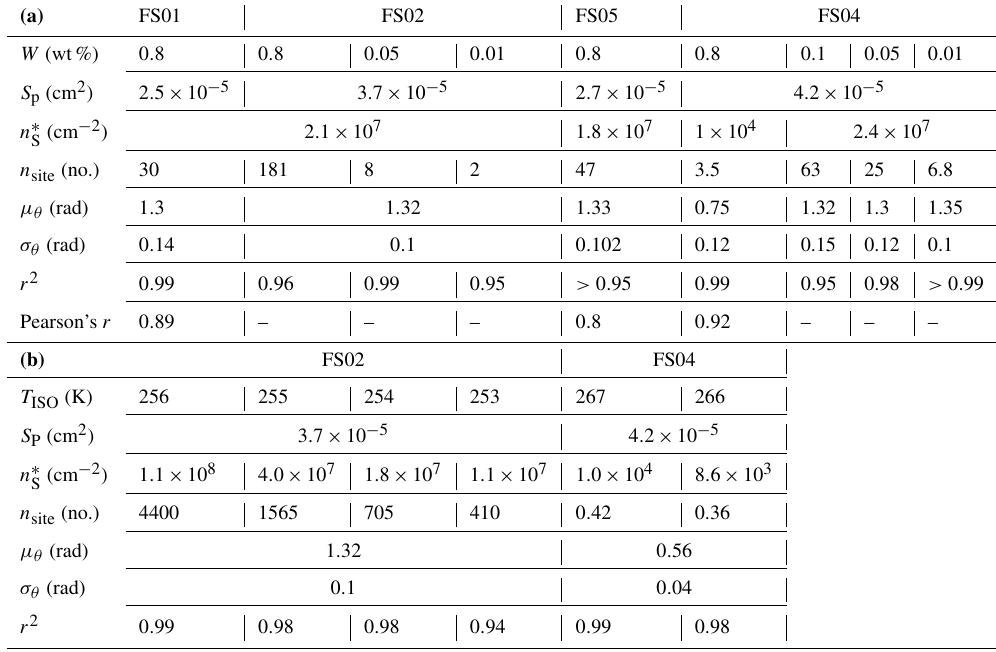
Table 2. (a) SBM parameters obtained by fitting the CR freezing curves. (b) SBM parameters obtained by fitting the ISO decay curves. The total particle surface area per droplet S p is given for 0.8wt% concentration and could be recalculated for all other mass concentrations. Pearson’s r correlation coefficient was calculated from the freeze–thaw experiments. Note that n ∗ value for the suspension